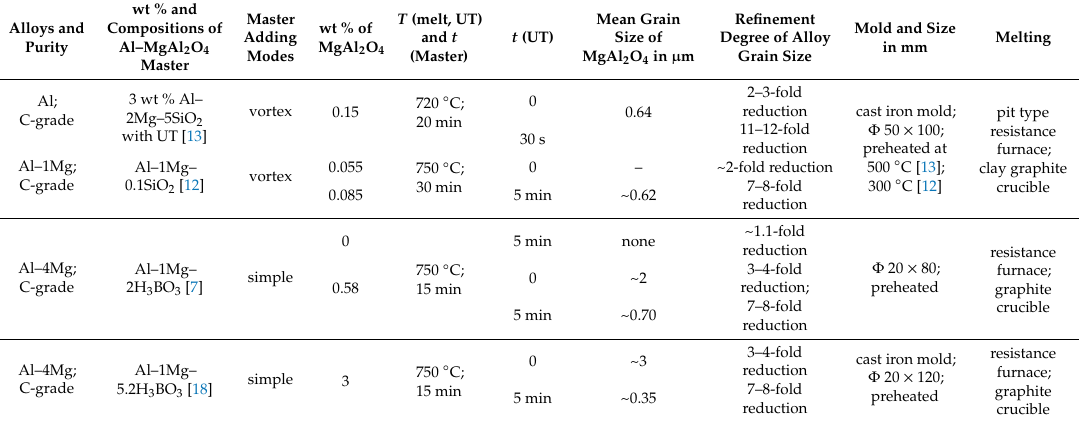
Table 1. The refinement degree of alloy grain sizes with di ff erent contents of MgAl 2 O 4 and di ff erent ultrasonic treatment (UT)